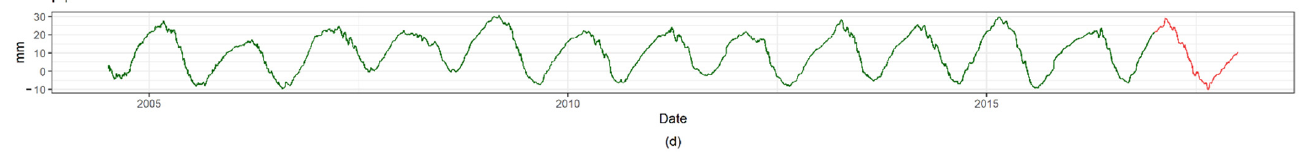
Figure 9. Series of direct pendulums. Training instances are colored in green and validation dates are colored in red. ( a ) Series of pendulum 1; ( b ) Series of pendulum 2; ( c ) Series of pendulum 3; ( d ) Series of pendulum 4.